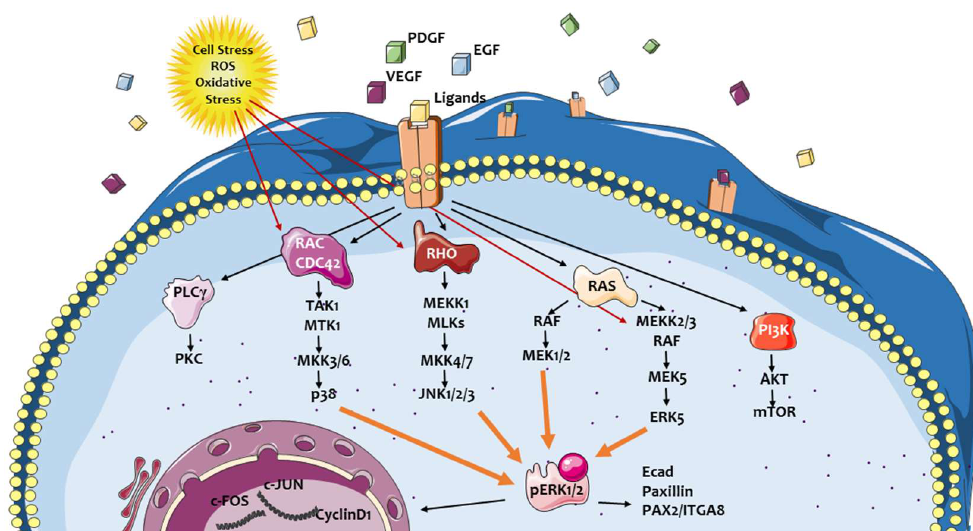
Figure 2. Mitogen-activated protein kinase (MAPK) cascades in activated, myofibroblast-like hepatic stellate cells (HSC/MFs). Pathways activated by major extracellular peptide ligands active on HSC/MFs or following oxidative stress and reactive oxygen species (ROS) generation.